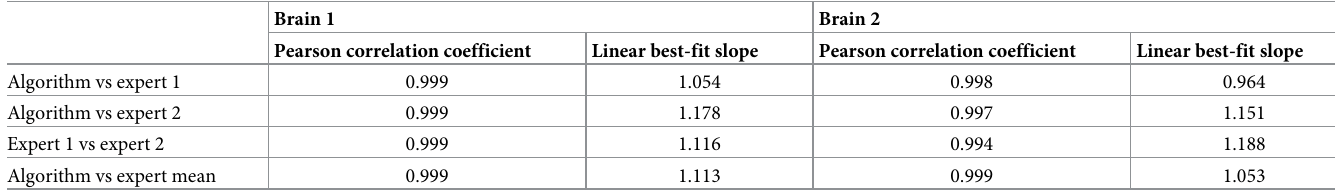
Table 4. Comparison between algorithm and expert cell counting.